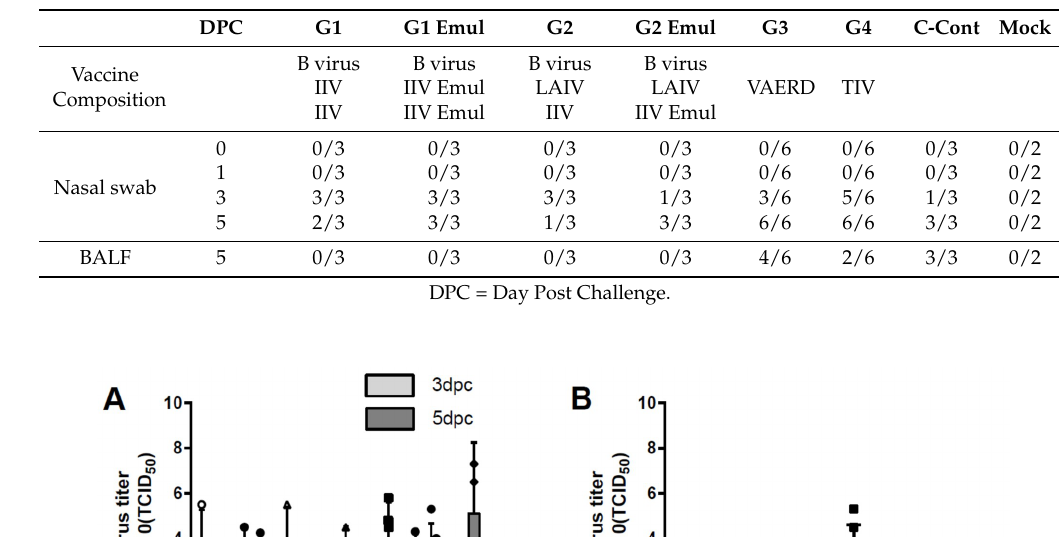
Table 3. Number of virus positive animals per group.